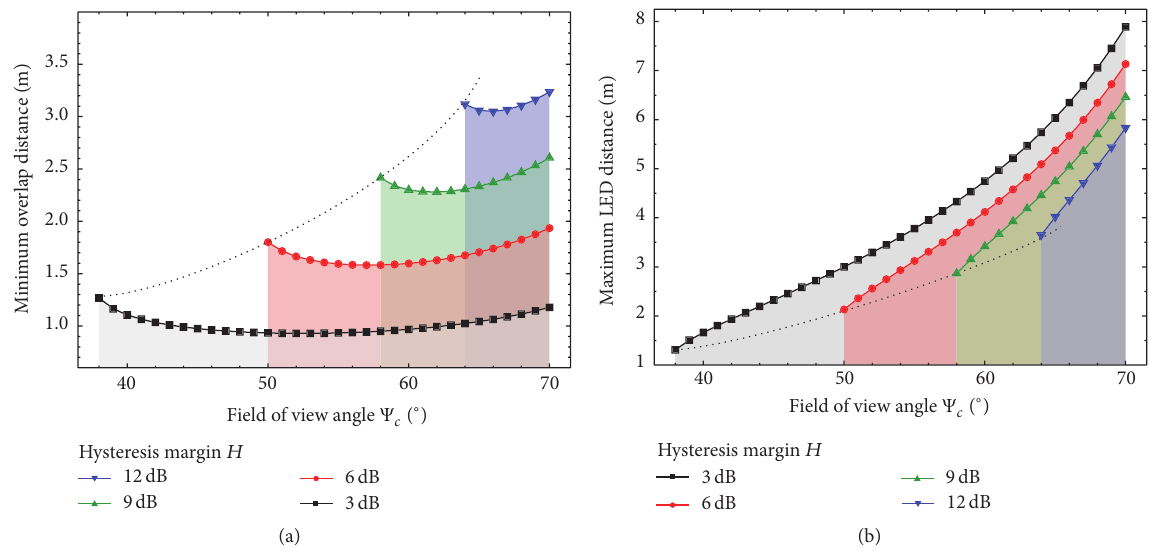
Figure 6: (a) Minimum overlap distance versus FOV and (b) maximum distance between 2 LEDs versus FOV at various hysteresis margin 𝐻 for supporting link